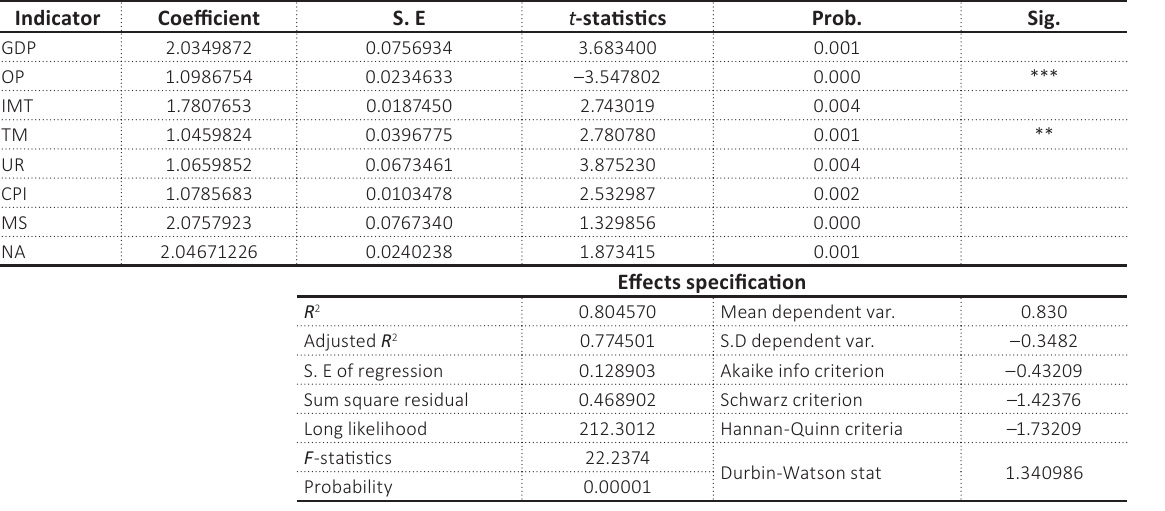
Table 3. Results of panel regression analysis (exposure scenario)